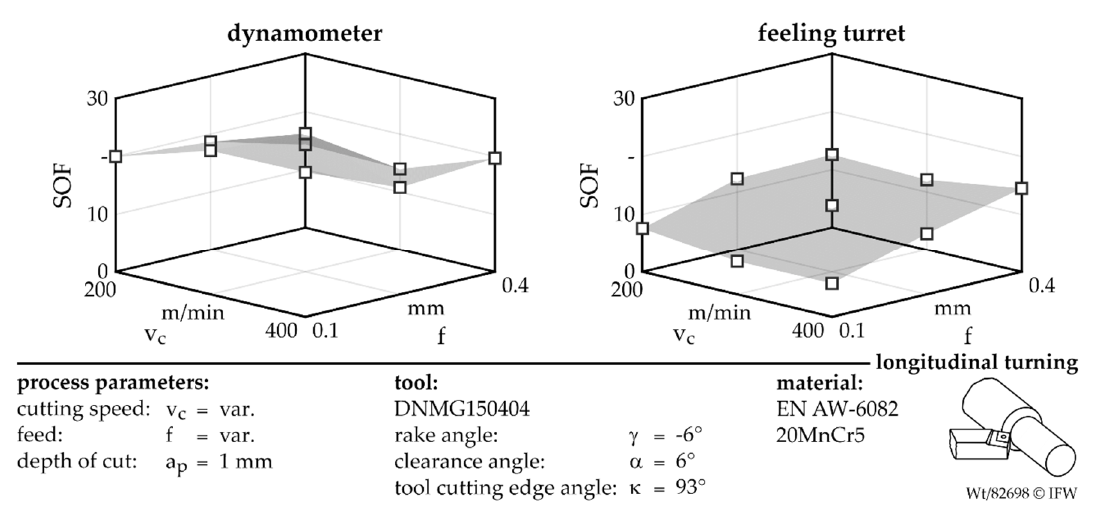
Figure 7. Material-specific cutting force for varying feed and cutting speed.